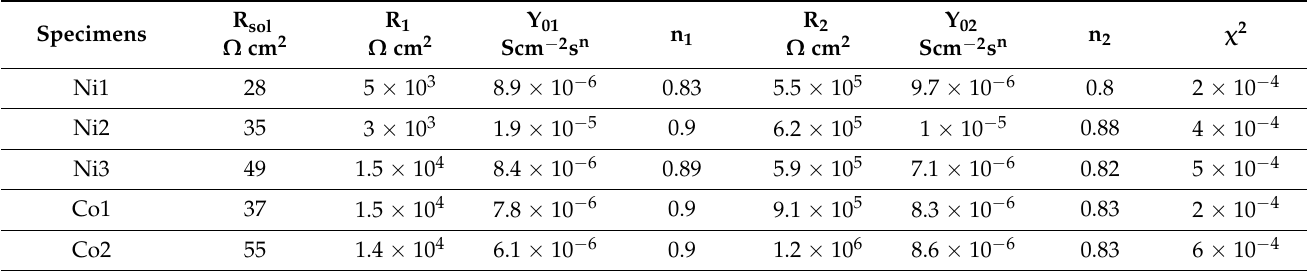
Table 3. Main parameters of the EC used for specimens Ni1, Ni2, Ni3, Co1, and Co2. R sol Specimens Ω cm